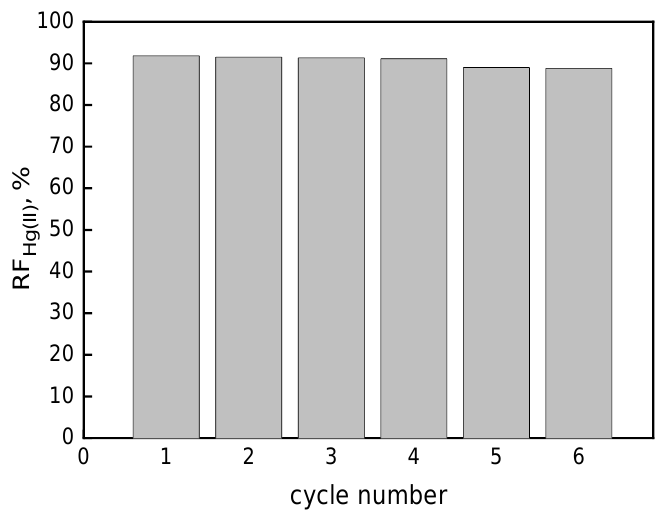
Figure 8. The recovery factor (RF) of Hg(II) vs. the cycle number. Source phase: 1.0 × 10 −6 M Hg(II), 0.1 M HCl membrane: 19 wt.% of CTA, 4 wt.% of KP, 77 wt.% of o -NPOE; receiving phase: 0.1 M NaCl.